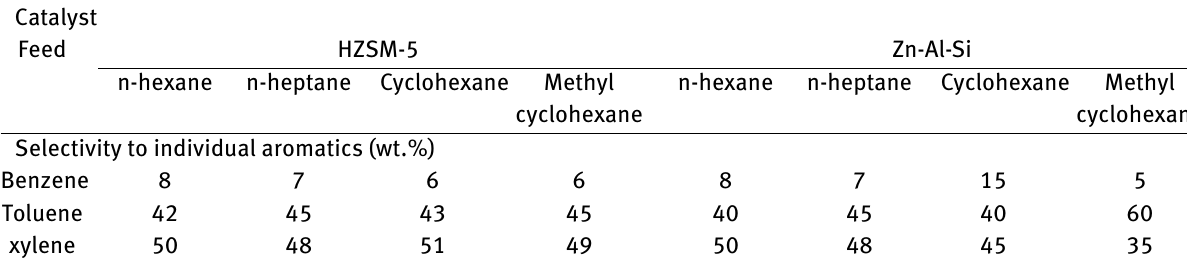
cyclohexane cyclohexane